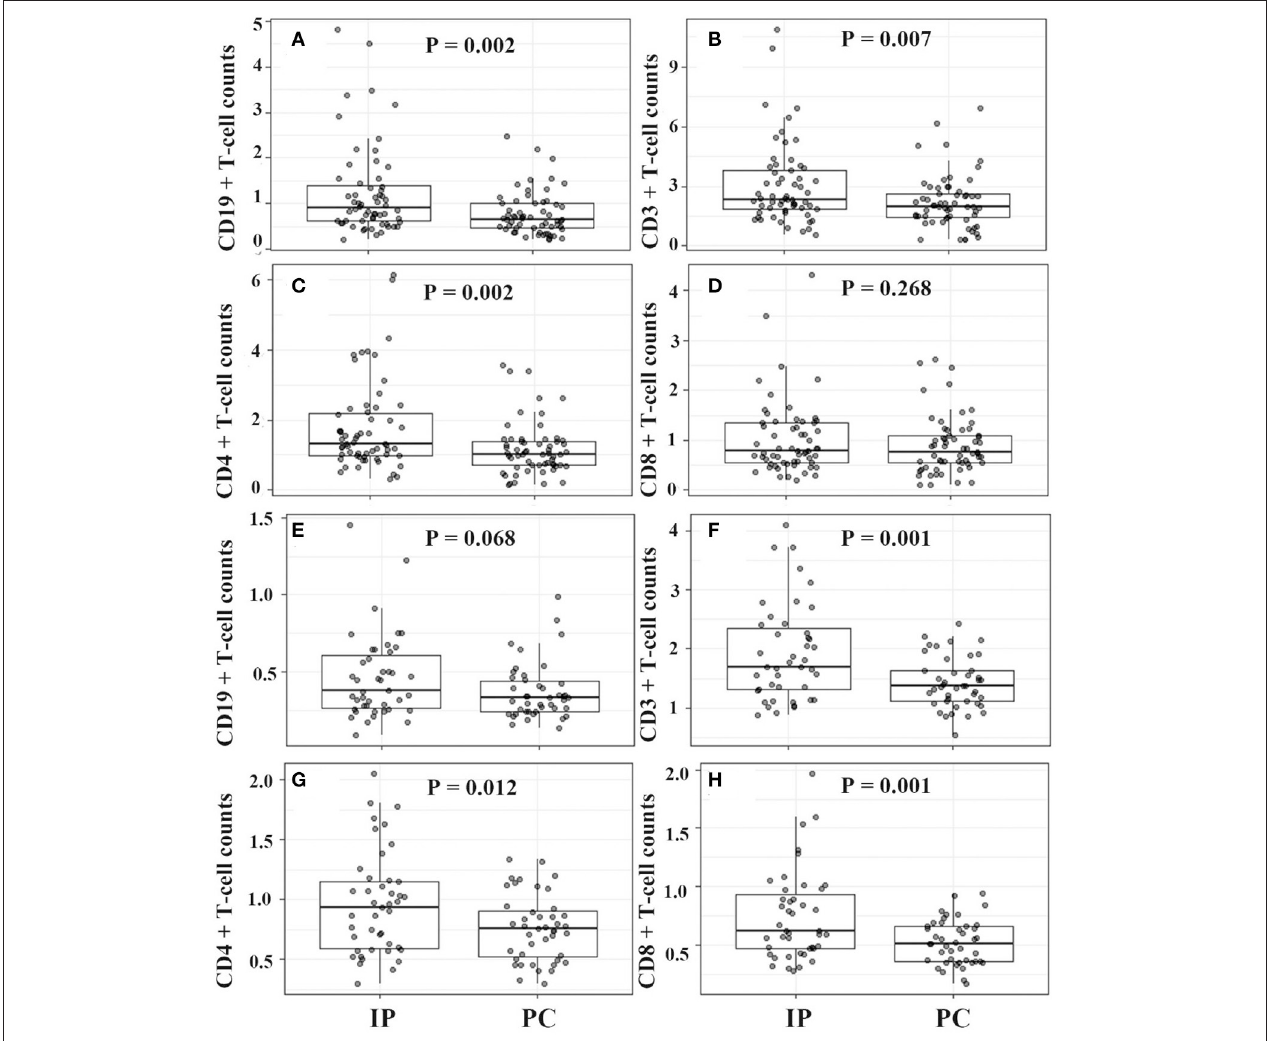
FIGURE 4 | Lymphocyte classification counts between IP and PC children ≤ 5 years (A–D) and > 5 years (E–H) after PSA. IP, interstitial pneumonia; PC, pulmonary consolidation; PSA, propensity score